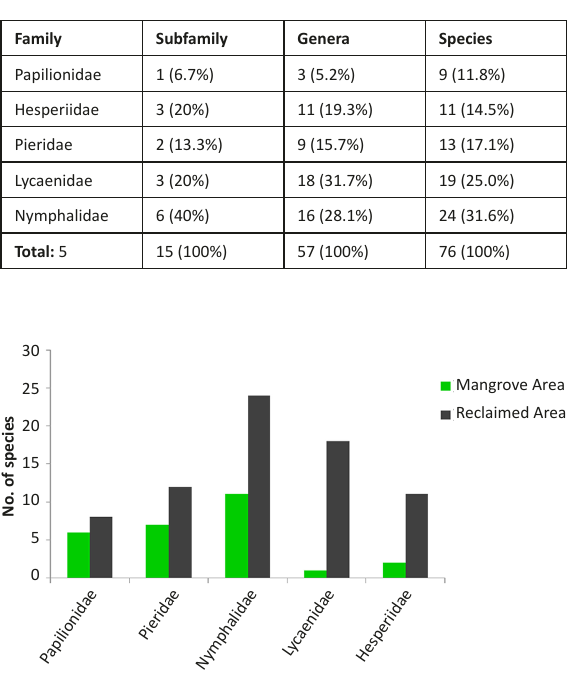
Table 3. Legally protected butterflies of Sundarbans under the Indian Wildlife (Protection) Act, 1972 (WPA).